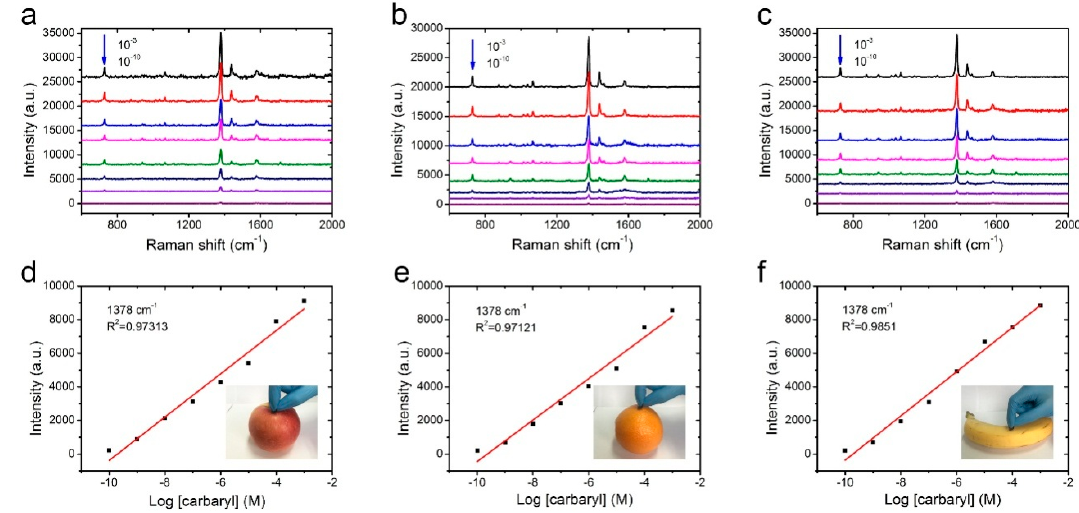
Figure 6. SERS spectra of the NW@PDA@AgNPs fabrics through swabbing extraction with different carbaryl concentrations on ( a ) apple, ( b ) orange, and ( c ) banana surfaces. The respective calibration curves for carbaryl on ( d ) apple, ( e ) orange, and ( f ) banana surfaces through swabbing extraction. As the concentration decreased from 1 × 10 − 3 to 1 × 10 − 10 M, the peak intensity of carbaryl pesticide